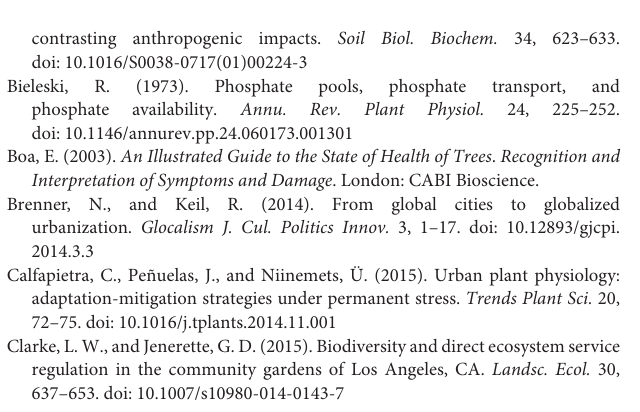
Supplementary Figure 1 | Pearson correlation matrix of the leaf functional traits. Trait values were scaled to zero mean and unit standard deviation in order to plot them on the same scale. ( ∗∗∗ p < 0.001, ∗∗ p < 0.01, ∗ p < 0.05). Supplementary Figure 2 | Hypothetical model of the structural equation model for effects of (A) soil nutrients and (B) micro-climate on leaf morphological and nutrient traits. Variables in oval and rectangular boxes are latent and observed variables, respectively. Single-headed arrows indicate a causal influence of one variable on another. Supplementary Figure 3 | Changes in leaf functional traits along the urban–rural gradient for all the selected species. Trait values were scaled to zero mean and unit standard deviation in order to plot them on the same scale. Solid and dashed arrows indicate significant and insignificant effects, respectively ( p < 0.05). Supplementary Figure 4 | Changes in (A–D) soil nutrients and (E,F) micro-climate along the urban–rural gradient, fitted with general linear models, with environmental factor as the response variable and distance as the predictor variable. Supplementary Table 1 | Basic profiles of the public parks selected. Supplementary Table 2 | Plant height and diameter at breast